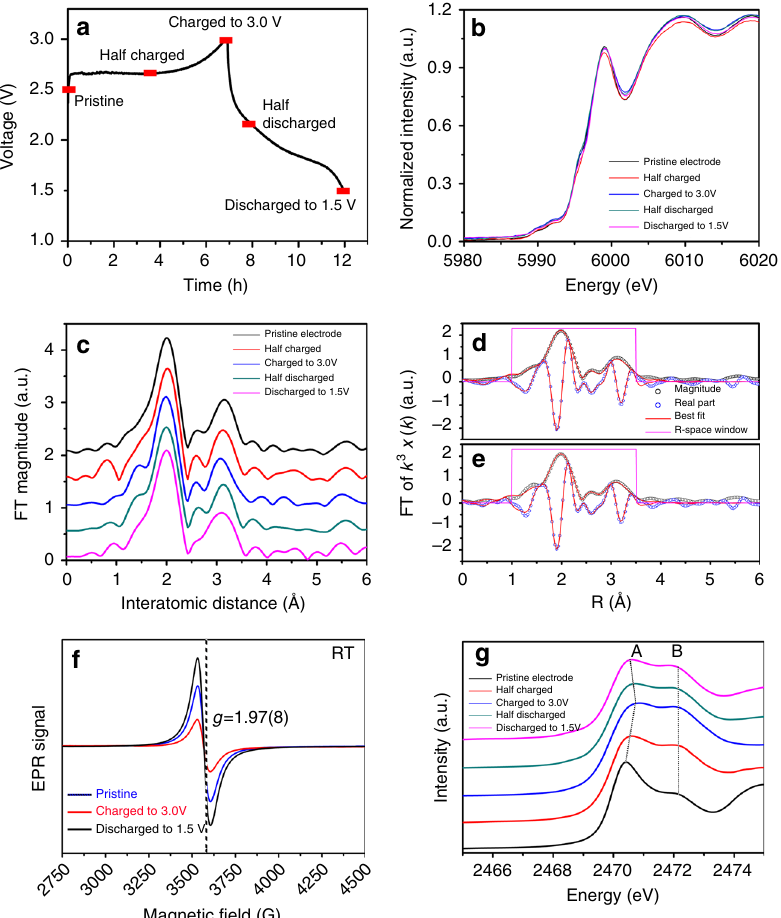
Fig. 4 Detection of Cr and S valance state during various charge-discharge stages. a Charge and discharge curves of NaCrS 2 electrode for ex situ XAS. b Cr K-edge XANES spectra of NaCrS 2 electrodes at various states. c Corresponding FT-EXAFS spectra of the NaCrS 2 electrode at various charge and discharge stages. Calculated ( solid red line ) and experimental ( solid and open circle ) FT-EXAFS spectra for d pristine and e fully charged samples. f EPR spectra of pristine NaCrS 2 , fully charged and discharged samples recorded at room temperature. g S K-edge XANES spectra of NaCrS 2 at the initial